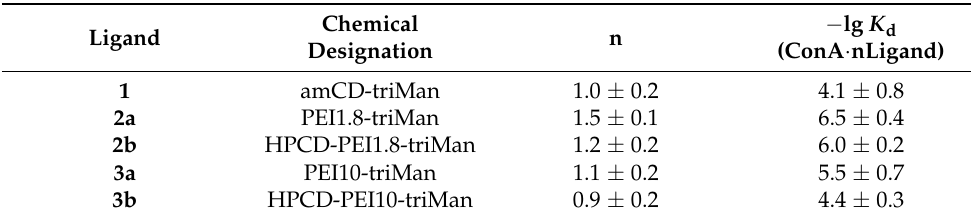
Table 2. ConA-ligand complexation parameters determined by FTIR spectroscopy: complex dissocia- tion constants and stoichiometry. ConA + nLigand (cid:10) ConA · nLigand. T = 22 ◦ C. C(Ca 2+ ) = C(Mn 2+ ) = 1 mM. Phosphate buffer solution pH =